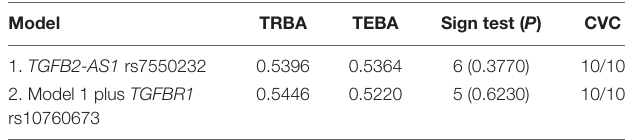
TABLE 6 | The results of GMDR of multiple loci and genes related to incidence of myopia. Model